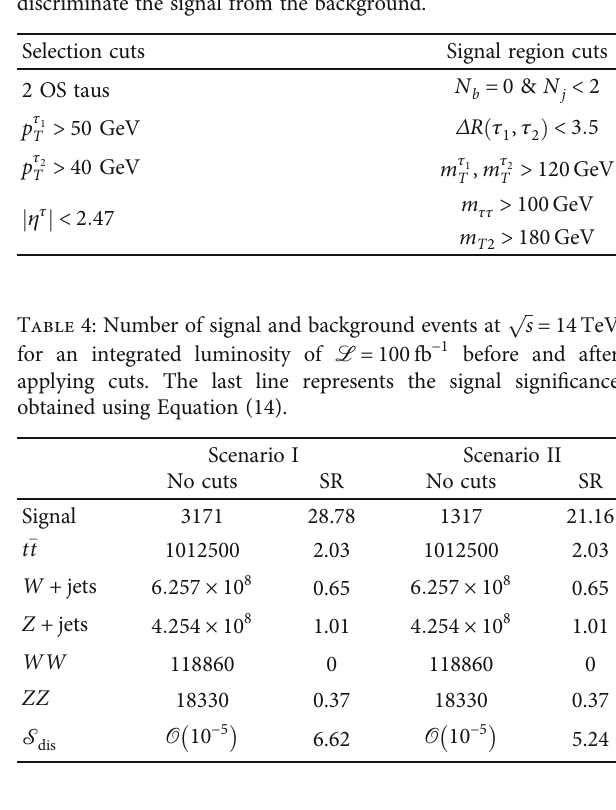
column shows the selection cuts that de fi ne the process. In the second column, we depict the selected cuts in order to discriminate the signal from the background.